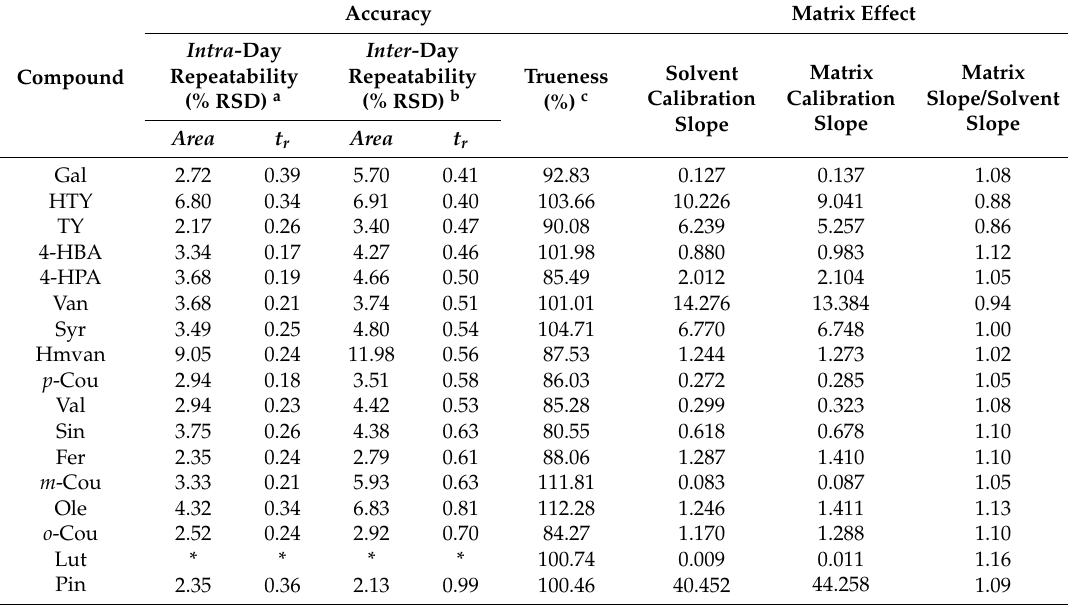
Table 1. Analytical parameters related to the evaluation of accuracy and matrix effect of the developed LC-FLD